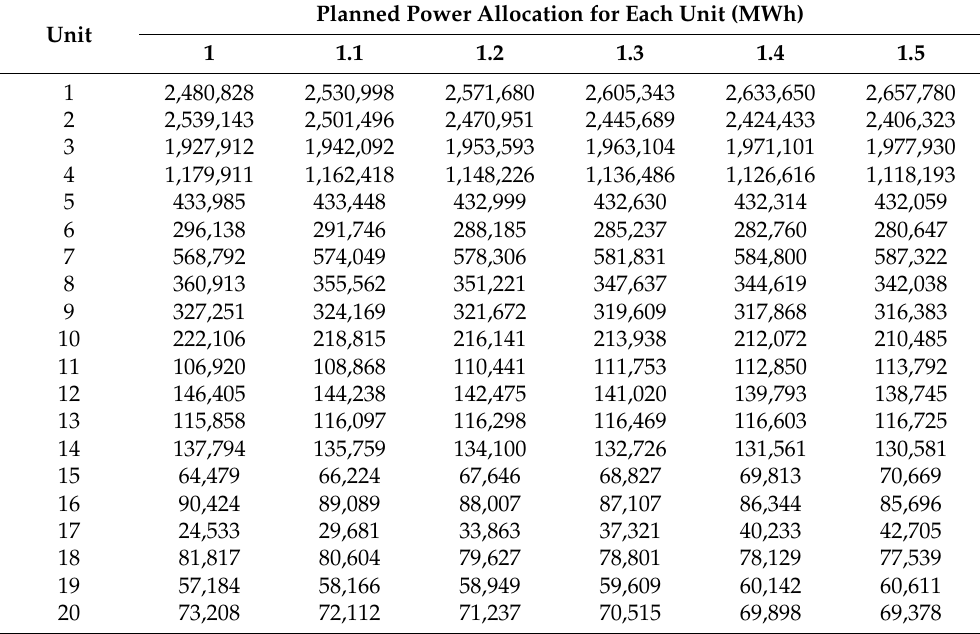
Table A7. Annual planned energy of each unit under different encouraged coefficient.